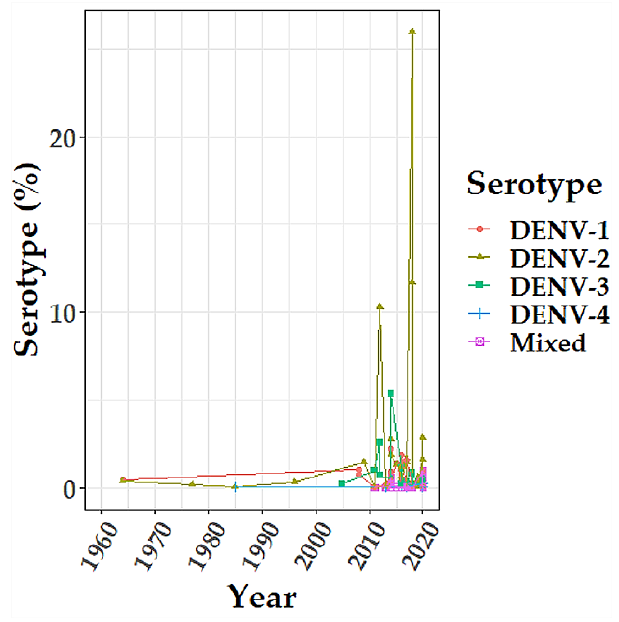
Figure 3. The longitudinal trend of dengue virus serotype proportion in Africa, 1964- 2020. The color codes represent DENV-1 (red), DENV-2 (dark khaki), DENV-3 (green), DENV-4 (blue), and Mixed serotype (pink). The graph was created using R software version 3.5.2 with a primary package ggplot2 at https://cran.r-project.org/bin/windows/base/old/3.5.2/ (accessed on 3 December 2020).